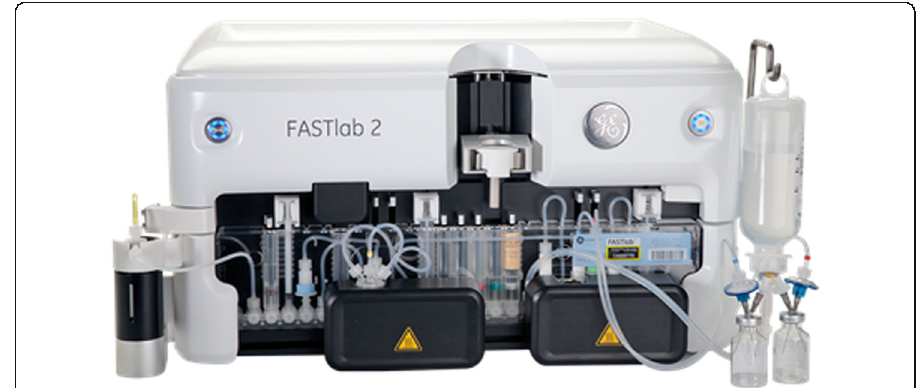
Fig. 2 FASTLab 2 equipped with dual run FDG DUO cassette (image courtesy of GE Healthcare)